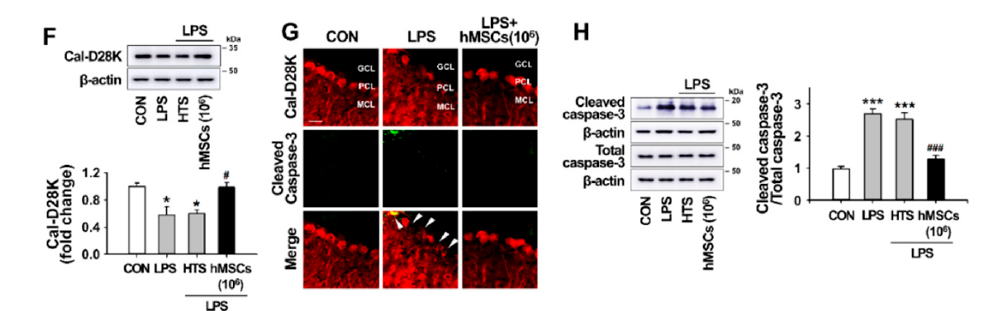
Figure 3. Beneficial e ff ects of hMSCs on behavioral impairments, inflammation, and apoptotic Purkinje cell death induced by LPS. ( A ) Rota-rod test after 4 weeks of hMSC transplantation in ICA mice. Significant di ff erences (*** p < 0.001; n = 5 per group) between CON or LPS + hMSCs and LPS alone or LPS + HTS groups were found starting at 11 weeks of age and for all testing weeks. ** p < 0.01